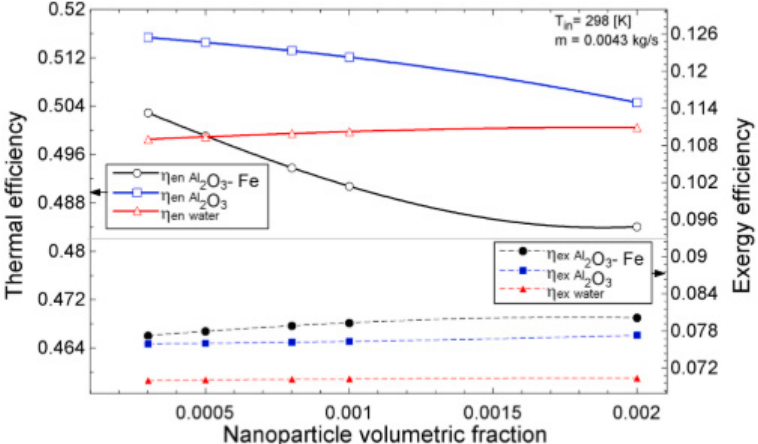
Figure 11. Thermal and exergetic efficiency performance of Al 2 O 3 -Fe and Al 2 O 3 nanofluid and water against increasing volumetric fraction for a flat plate collector application (Adapted from Okonkwo et al. [112]).